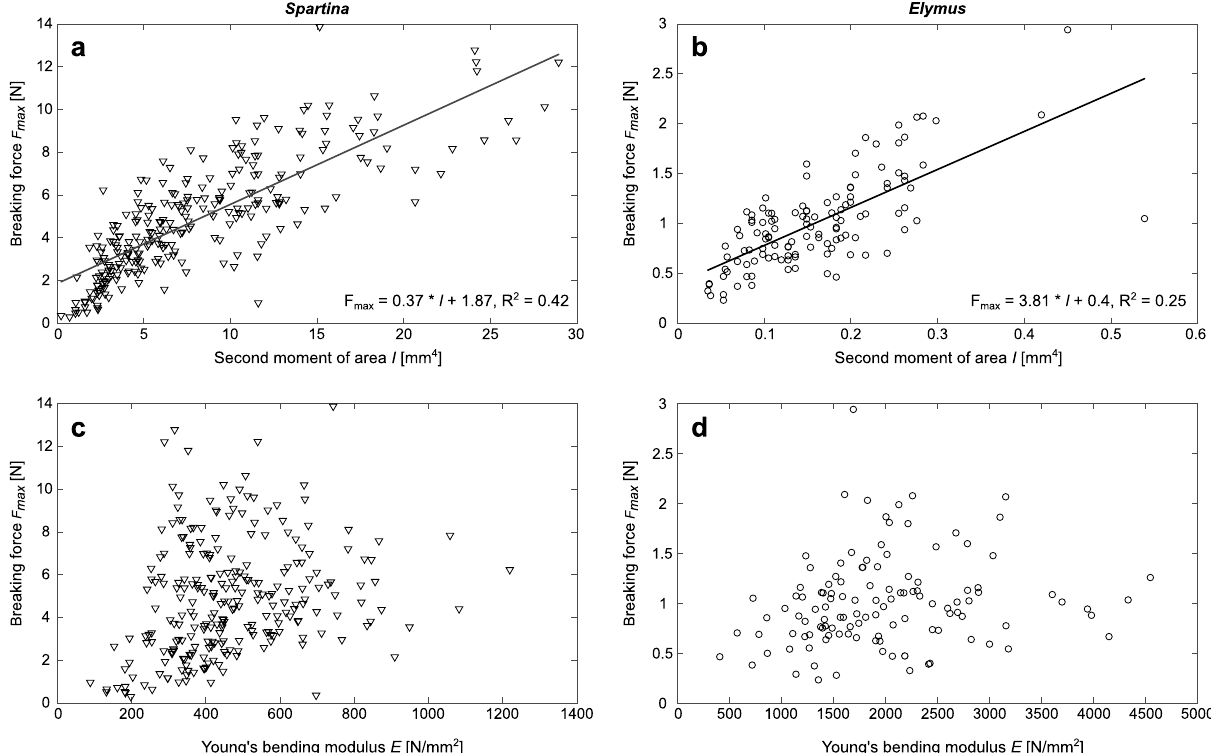
Figure 1. Relationship between breaking force F max and vegetation traits. ( a , b ) relationship for the second moment of area I ; ( c , d ) relationship for Young’s bending modulus E. Plots are provided for Spartina ( a , c ) and Elymus ( b , d ). Weak linear relationships are given for I but not for E . Note the different x-axes ranges for the two